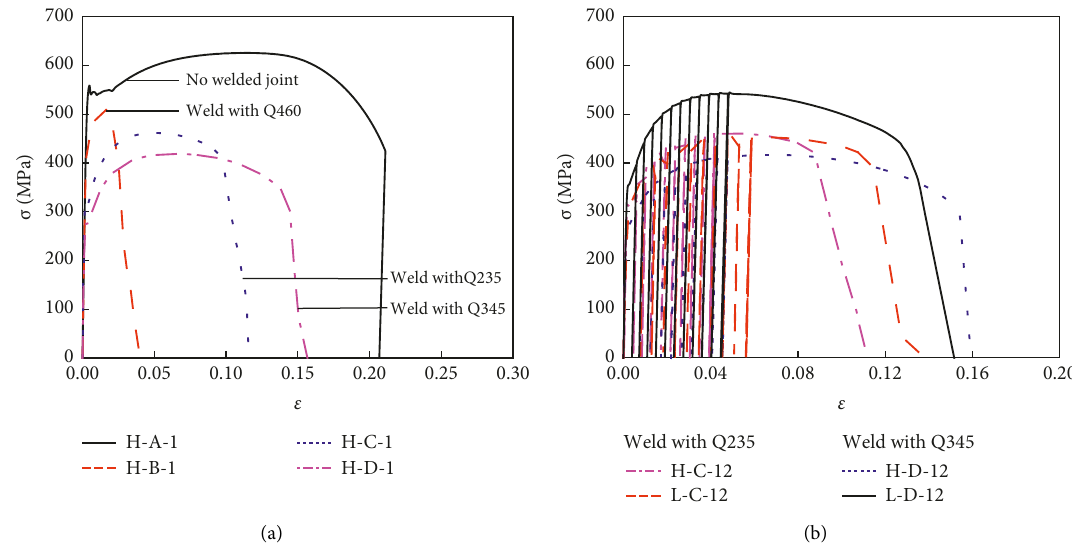
Figure 6: Stress-strain curves of welded material specimens with different material strengths. (a) Material specimens in the NM1 loading pattern. (b) Material specimens in the NM12 loading Figure 7. Group R-A consists of rod specimens without welded joints. As depicted in Figure 7(a), the specimens